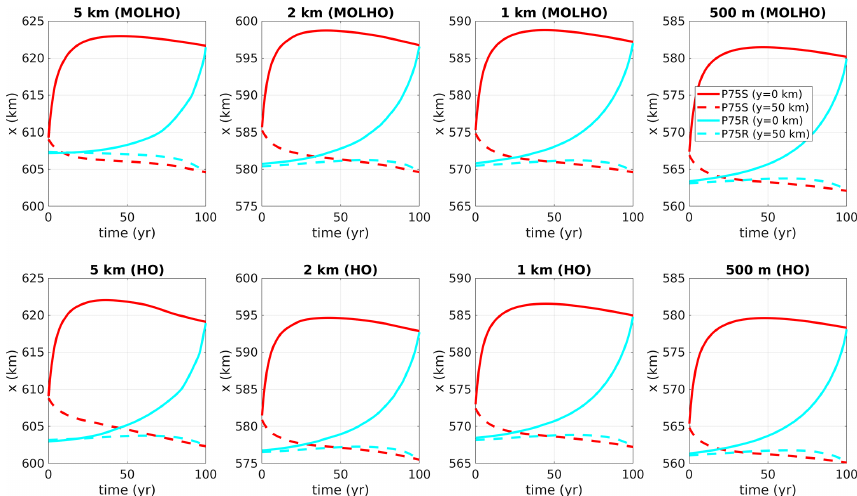
Figure 6. Time-dependent grounding line positions of the MISMIP3D experiments obtained with different mesh resolutions. Solid lines are the grounding line positions at y = 0. Dashed lines are the grounding line positions at y = 50 km. Red lines are the positions obtained during the basal friction perturbation experiment (P75S). Blue lines are the positions obtained during the first 100 years after restoring the friction coefficient to its original value (P75R). Note that the x axes are reversed for the P75R experiment